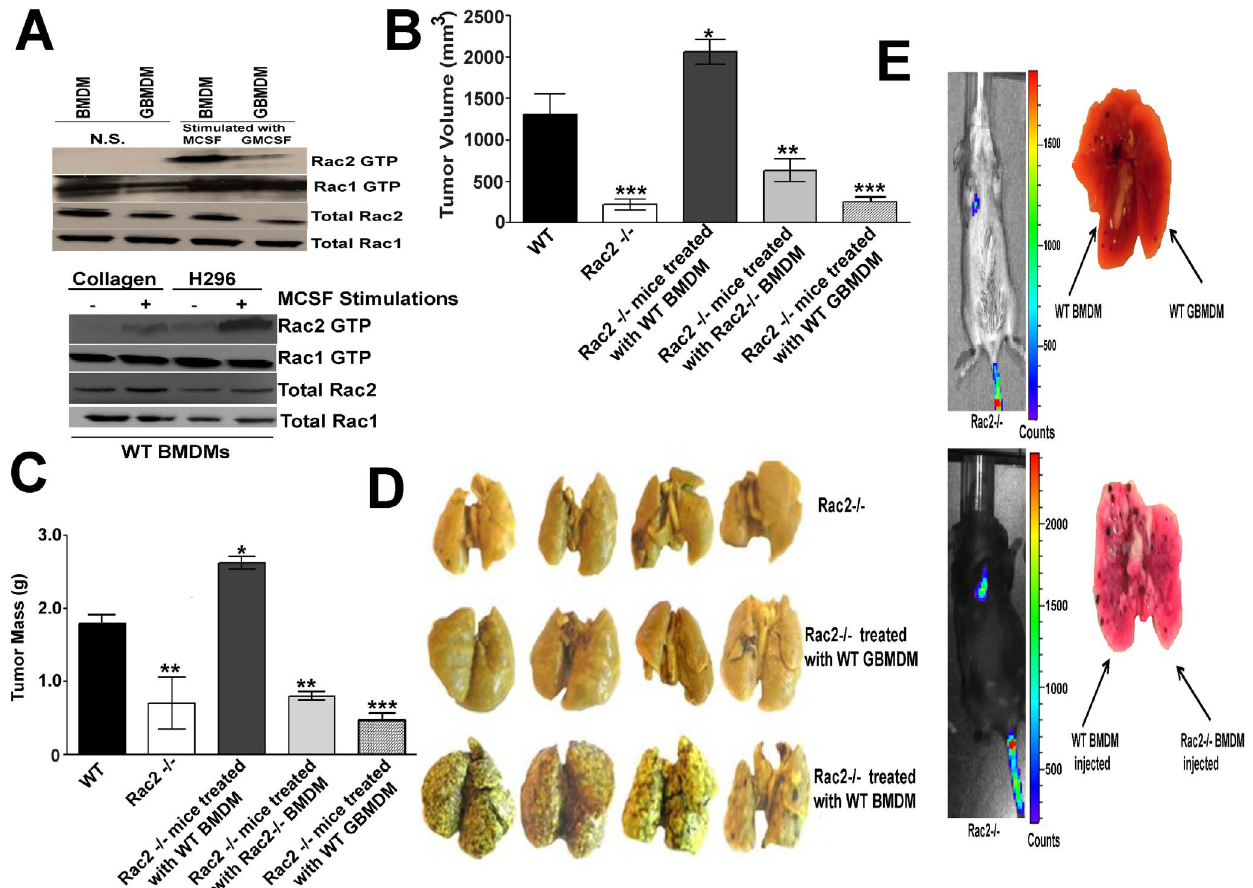
Figure 6. Reversal of the metastatic defect by injection of macrophages cultured in MCSF. (A) Upper panel shows that MCSF signaling differentially activates Rac2 while GMCSF signaling does not result in significant Rac2 activation. BMDMs or GBMDMs cultured in MCSF or GMCSF for 7 days were serum starved for 4 hrs and stimulated with 50 ng/ml of MCSF or GMCSF for 15 min followed by Rac2 GTP pull down assays as described in Materials and Methods. Lower panel shows the differential activation of Rac2 when M h s are costimulated through the MCSFR and a 4 b 1 integrin. WT BMDMs cultured in MCSF for 7 days were serum starved for 4 hrs, trypsinized and were allowed to engage with a 4 b 1 ligand (H296) or a 2 b 1 ligand (collagen), followed by MCSF stimulation (50 ng/ml) for 15 min and Rac2 GTP pull down assay as described before. (B & C) Tumor volume (B) and mass (C) of LLC tumors grown in Rac2-/- mice treated with or without 1 million WT BMDMs or Rac2-/- BMDMs or WT GBMDMs. After 5 days of LLC tumor inoculation, Rac2-/- mice were treated either with 1 million WT BMDMs or GBMDMs or Rac2-/- BMDMs or every third day, until tumors were removed on day 21. Values are mean 6 SEM ( n =6-8). Statistical significance is assessed by two sample t -test where *denotes P , 0.05, ** denotes P , 0.01 and *** denotes P , 0.001. Experiment was repeated three times with similar results. (D) Reversal of B16 metastasis by injection of WT BMDMs and not by WT GBMDMs in Rac2-/- mice. Figure shows representative photograph of pulmonary metastatic foci produced 15 days after intravenous injection of B16F10 cells in Rac2-/- mice and treated with 1 million WT BMDMs or WT GBMDMs. One dose of 1 million BMDMs or GBMDMs were given to Rac2-/- mice two days before inoculating 5 6 10 5 B16F10 cells intravenously followed by treatment with 1 million BMDM or GBMDM every third day, lungs were harvested on day 15. Data are representative of three independent experiments with 6–8 mice in each group. (E) Reversal of metastatic defect in Rac2-/- mice by local injections of 1 million WT BMDMs in the right lobe of lungs and 1 million WT GBMDMs or Rac2-/- BMDMs in the left lobe of Rac2-/- mice, followed by tail vein injections of B16 luciferase cells (5 6 10 5 ) after 2 days. The luciferase signal was monitored every third day on IVIS by injecting luciferin, until lungs were harvested on day 15 (n=5). Data are representative of two independent experiments with 5–6 mice in each